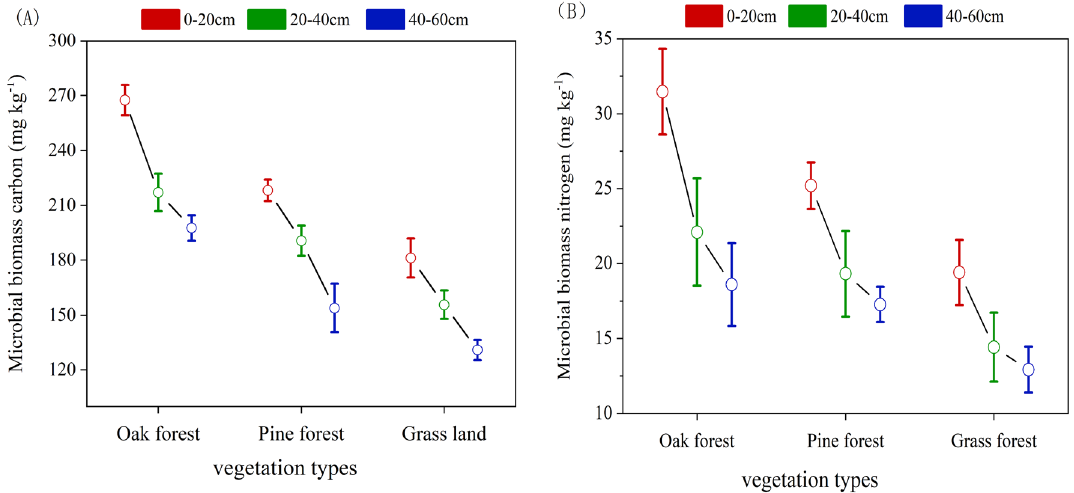
Figure 5. Variations in MBC and MBN affected by different vegetation types and soil